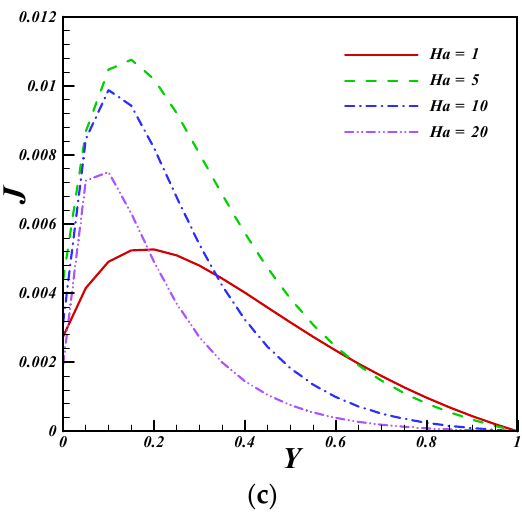
Figure 4. Effect of Hartmann number (Ha) on velocity ( U ); induced magnetic field ( B ) and induced current density ( J ) distributions when V 0 = 1, Pm = 1, φ = 0.04, Pr = 6.8.